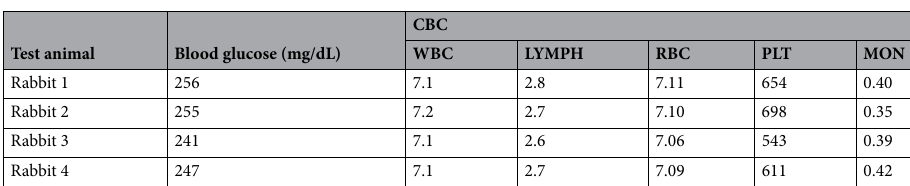
Table 8. Hematology and blood glucose results. Reference range (as per pets and vets clinic Islamabad— Pakistan: WBC: 5.2–13.5, LYMPH: 3.2–9.0, RBC: 5.00–7.60, PLT: 100–712, MON: 0.1–0.6).